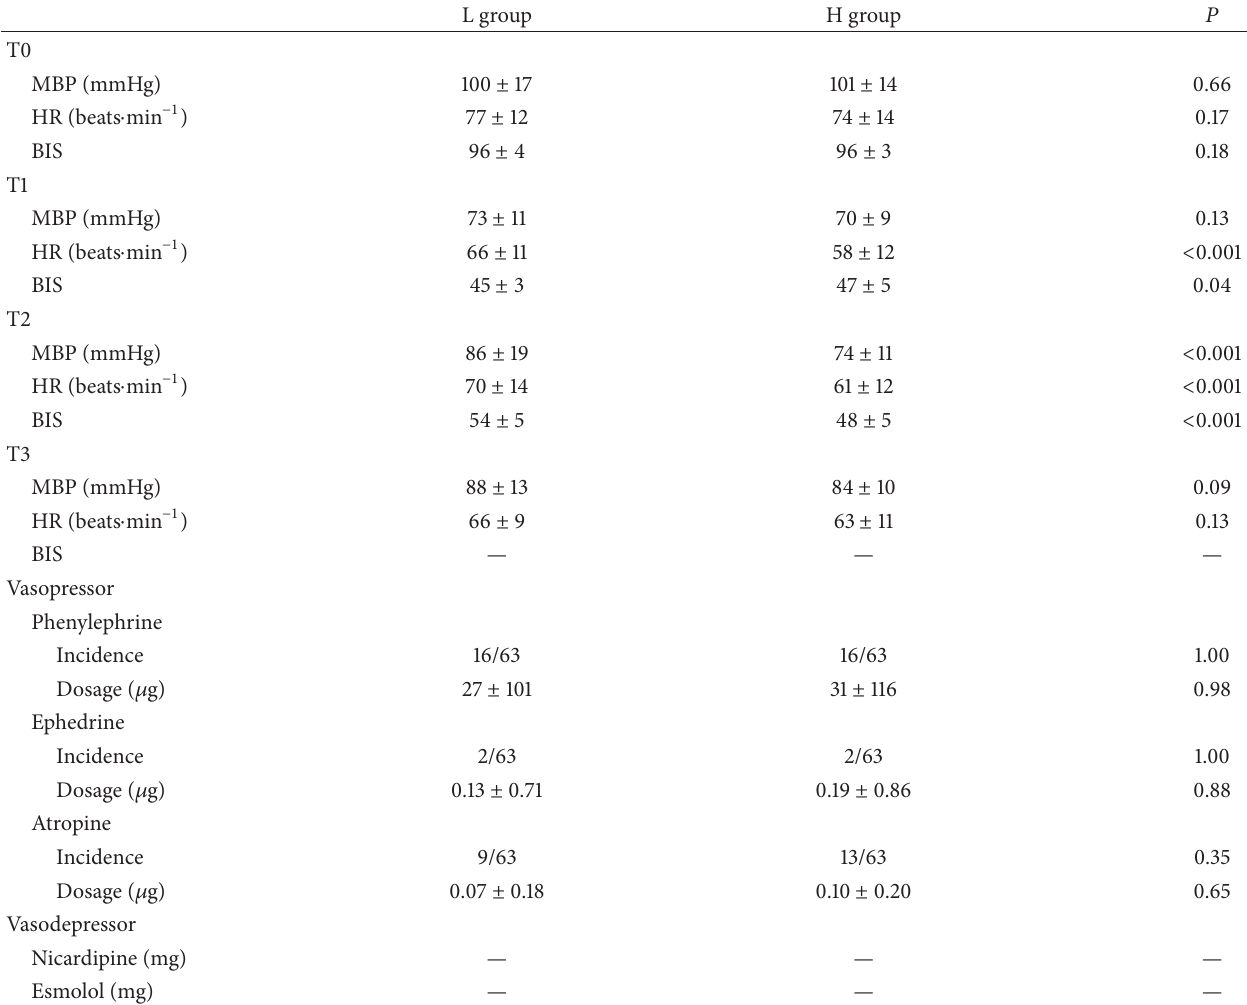
Table 2: Haemodynamic parameters and bispectral index during